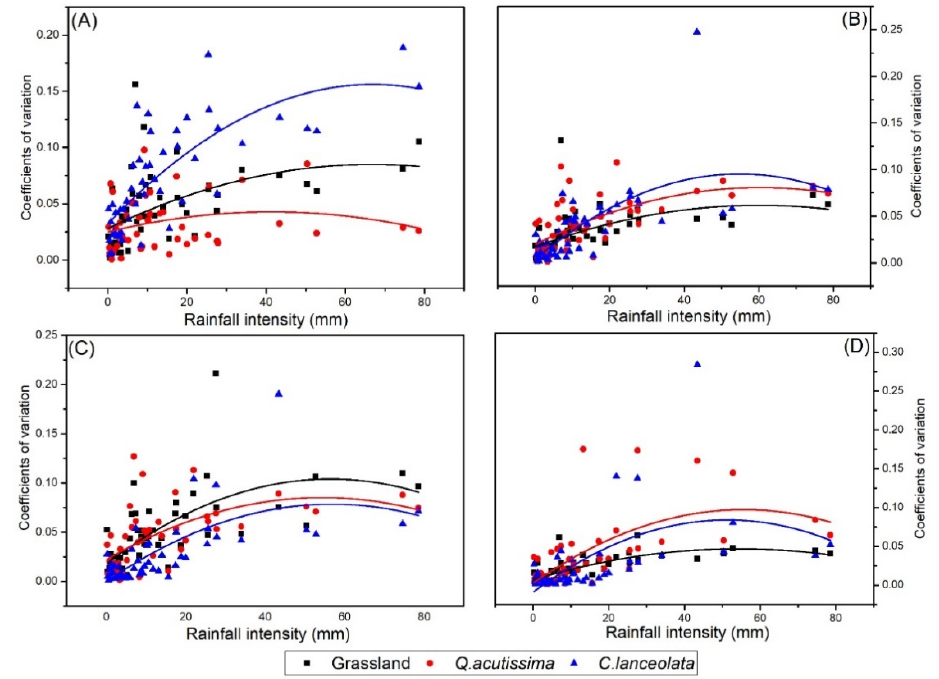
Figure 11. Variation coefficient of soil moisture content with different rainfall intensities ( A ), 5 cm soil layer ( B ), 10 cm soil layer ( C ), 15 cm soil layer ( D ), 40 cm soil layer.